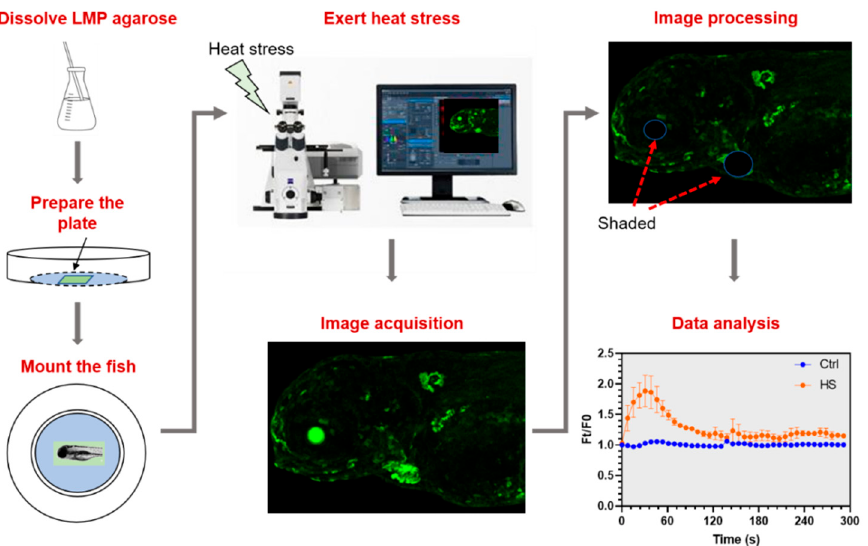
Figure 3. Workflow of the protocol to analyze in vivo activities of Ca 2+ signaling triggered by heat stress. Low melting-point (LMP) agarose was melted and poured into a confocal dish. After solidification of the LMP agarose, a tiny pit was made in the middle of the agarose plane. A larva anesthetized with MS-222 was put into the pit. The dish was placed onto the stage of a confocal microscope and orientation of the larvae was adjusted. After that, Z-stack time-lapse imaging was initiated immediately upon addition of hot water into the dish. Taking into account strong basal fluorescence of the eyes and the heart, these organs were shaded before measuring fluorescence intensity. Finally, the time-lapse fluorescence intensity data were plotted to illustrate the dynamics of Ca 2+ signaling elicited by heat